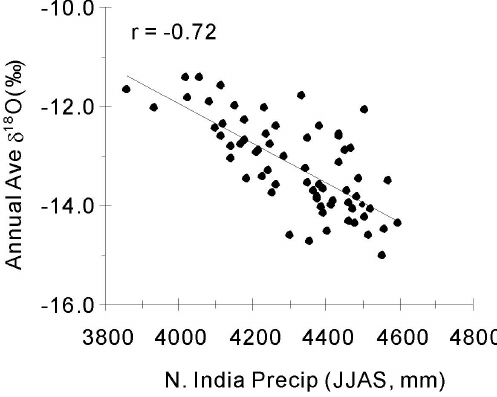
Fig. 7. Scatterplot of 5-yr running mean δ 18 O values and total North India precipitation,